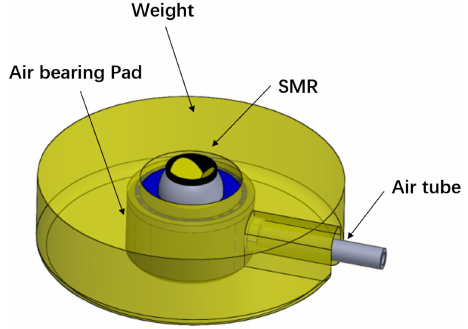
Figure 1. Schematic diagram of the non-contact